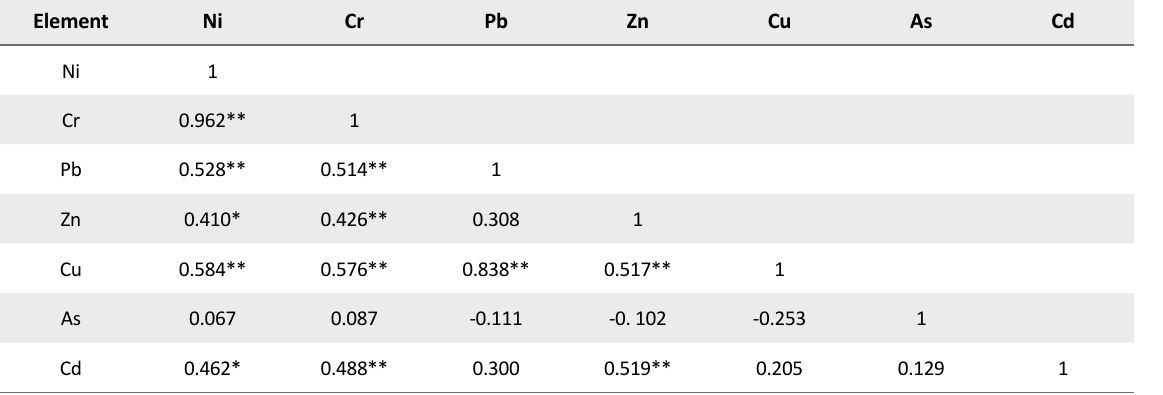
Table 7. The spearman correlation of toxic element concentrations (mg/kg) at the studied stations Element Ni Cr Pb Zn Cu As Cd